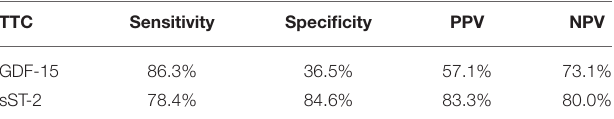
TABLE 3 | Rates for sensitivity, specificity, positive and negative predictive value for all tested biomarkers in TTC and ICMP patients.